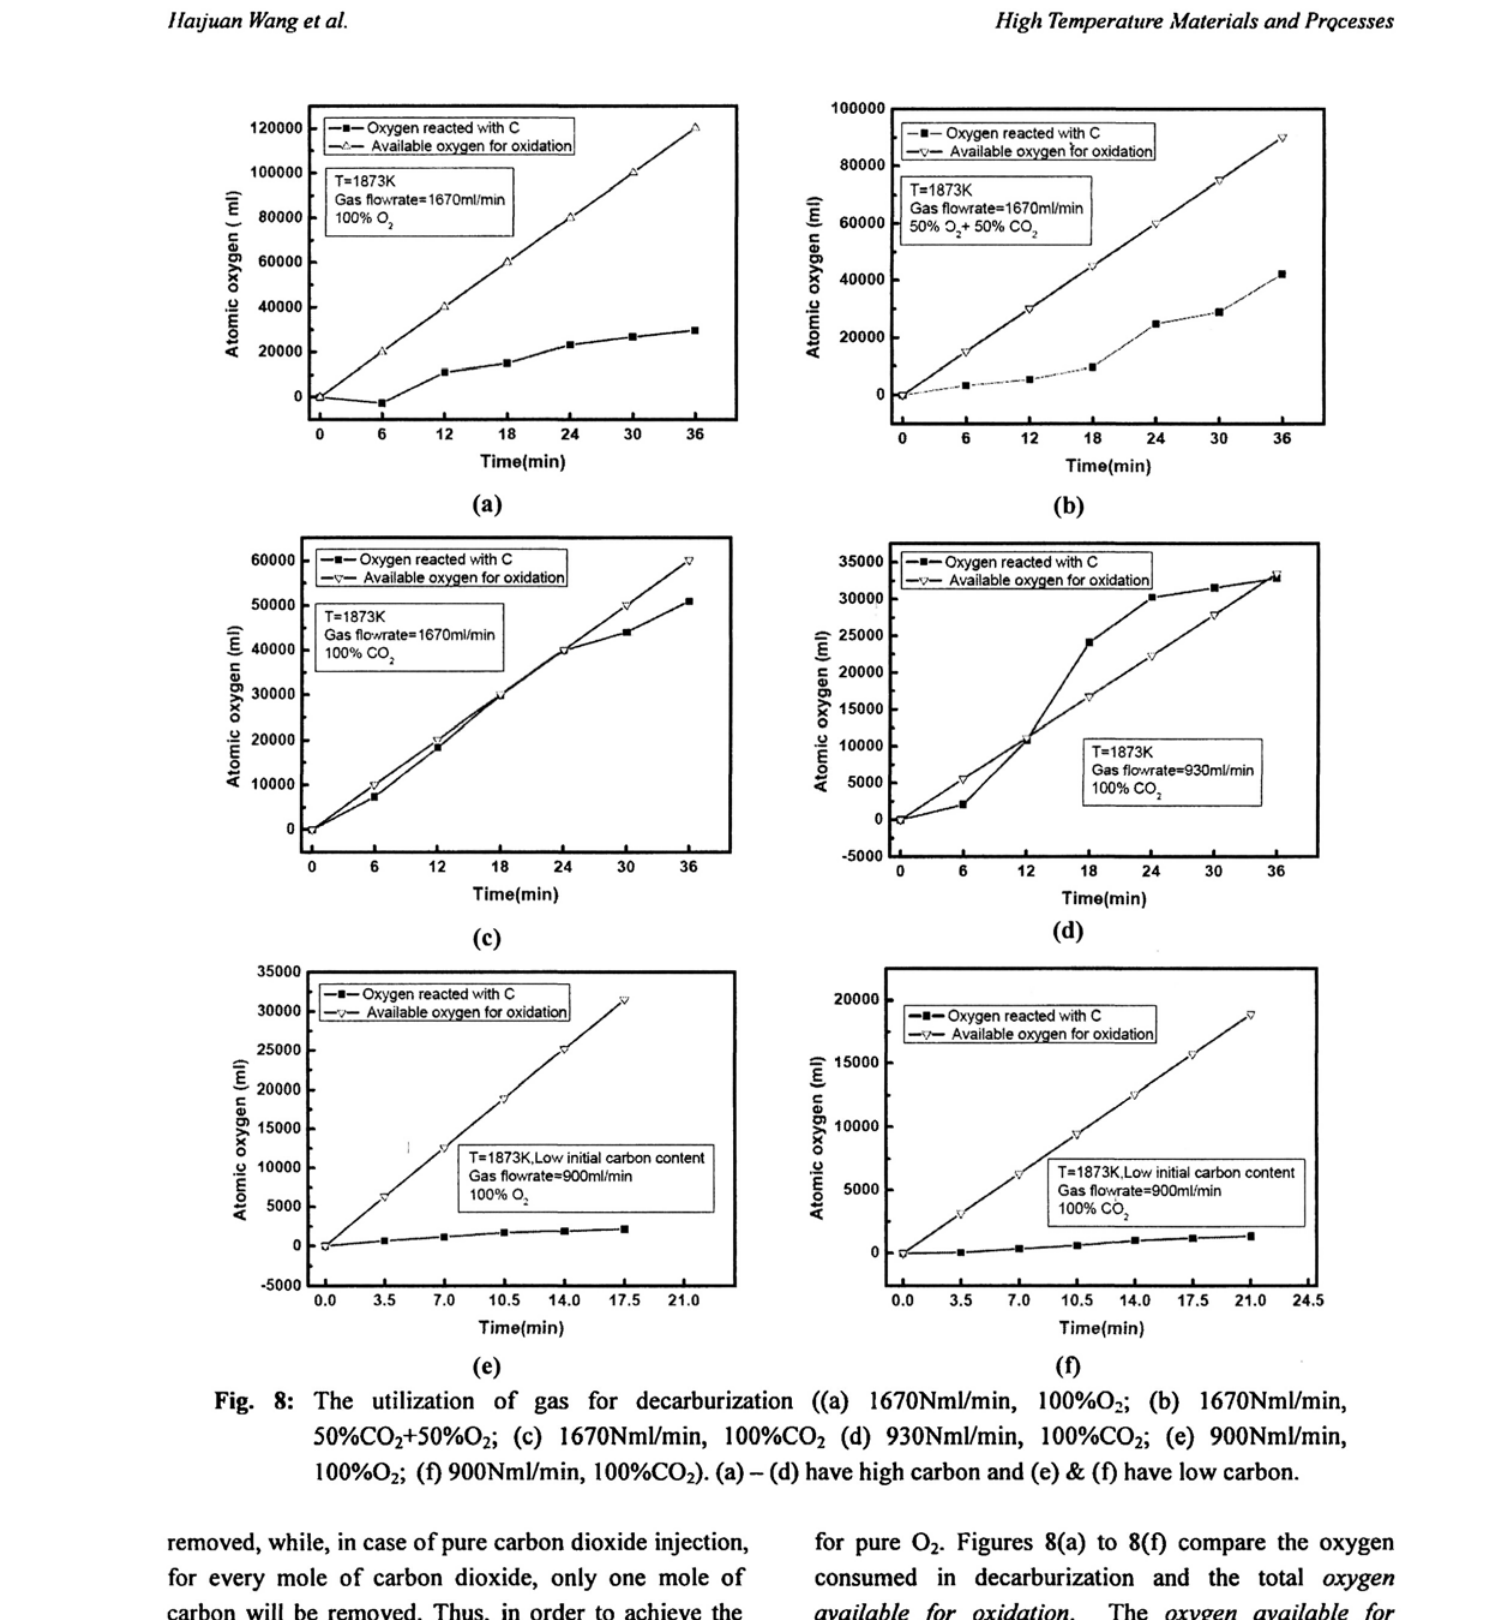
(d) 930Nml/min, 100%CO 2 ). (a) - (d) have high carbon and (e) & (f) have low 2